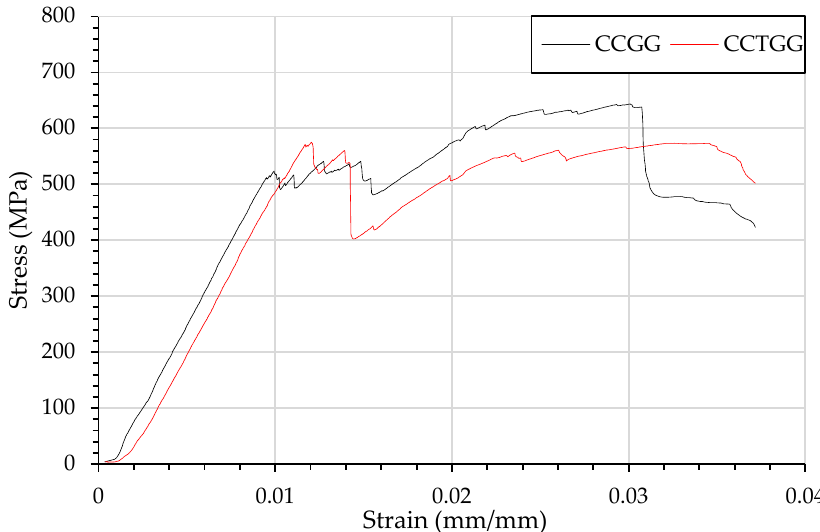
Figure 10. Flexural testing using three-point bending of composites beams and resulting stress strain curve of CCGG and CCTGG.